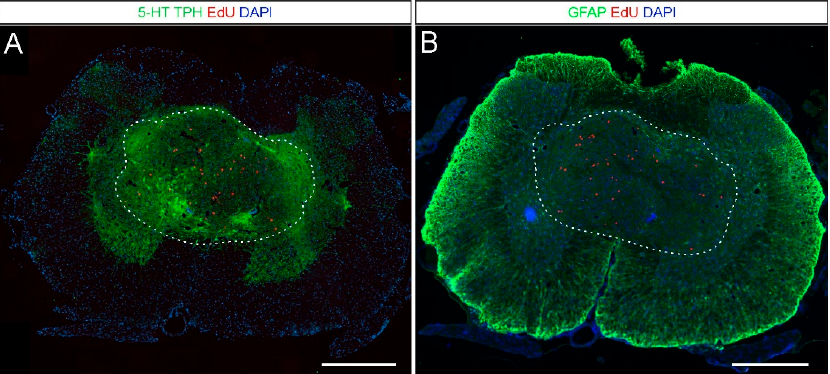
Figure 2. Representative immunofluorescent staining of two cross-sections from the same rat (about 180 µm apart) demonstrating the integration of the grafted tissue into the host spinal cord. ( A ) The location of the grafted tissue (marked by a dashed line) was estimated by the presence of 5-HT/TPH (green) positive neurons, their fibers, and EdU positive nuclei present exclusively in the cells of embryonic origin (red). Please note that several 5-HT/TPH-positive neurons are located close to the graft border and that there is the robust serotonergic fiber innervation of the spinal cord areas outside the graft region (i.e., the ventral horns). ( B ) There were no reactive astrocytes detected at the edge of the graft region (GFAP; green). Scalebars: 500 µm. Abbreviations: 5-HT: serotonin; TPH: tryptophan